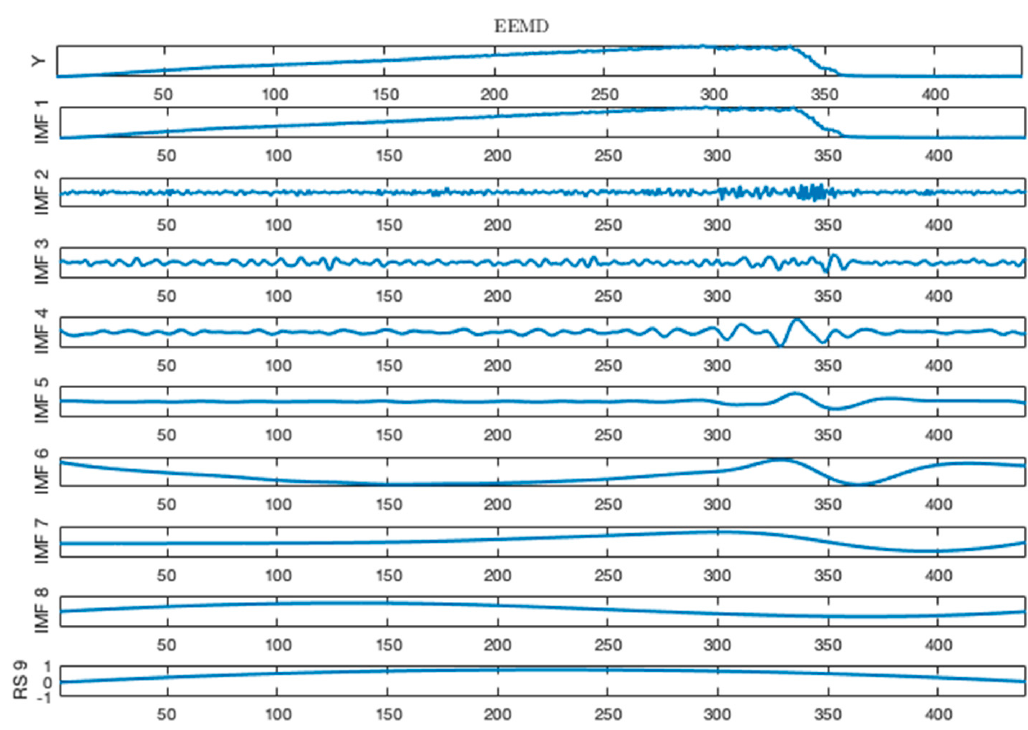
Figure 6. Ensemble Empirical Mode Decomposition (EEMD) of “Yangdong Line.”